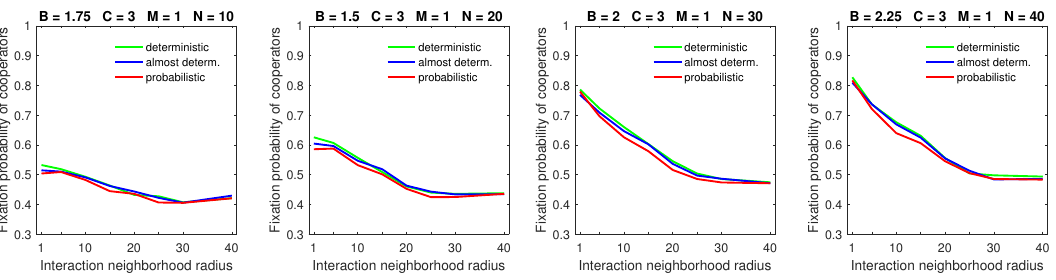
Figure 10. Deterministic dispersal results in slightly higher fixation probabilities of cooperators for a low mobility rate and a large dispersal range. In all graphs, R =